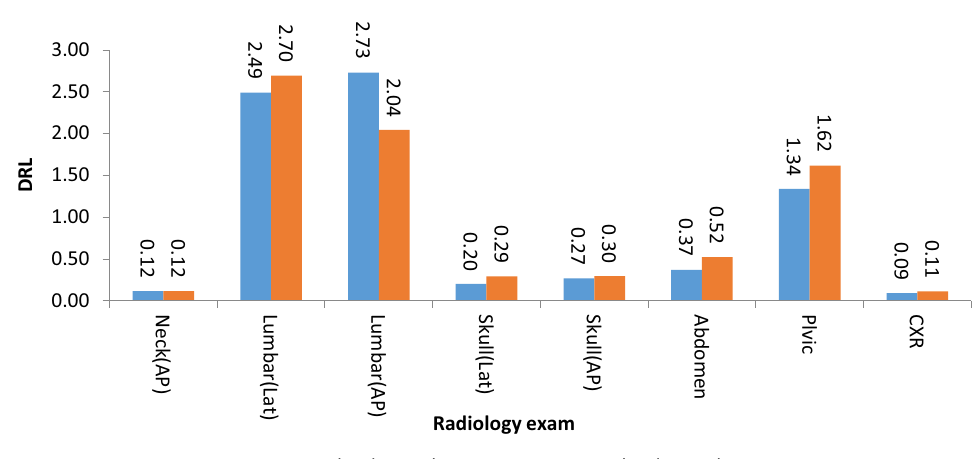
Fig. 1 DRL values for different radiology